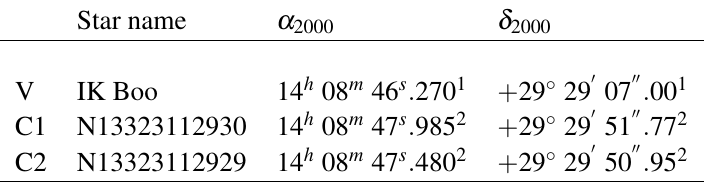
Table 1 The coordinates of IK Boo and the comparison